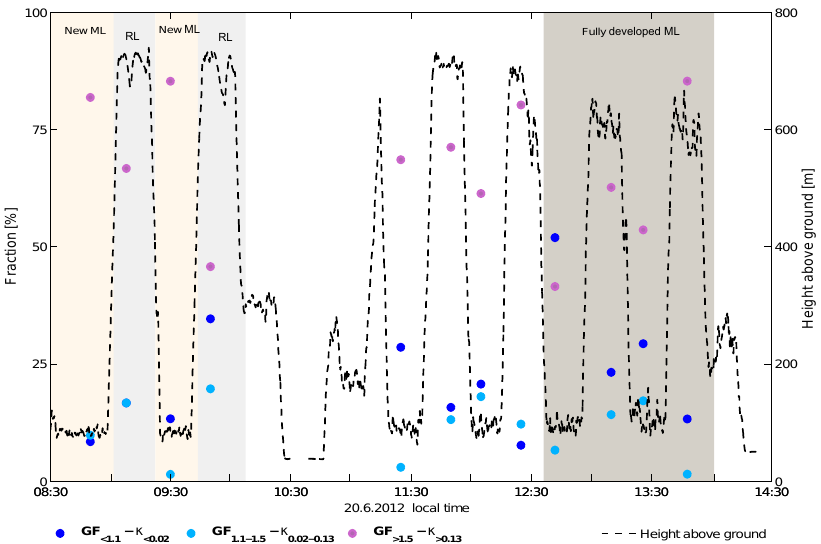
Figure 4. Time series of the mixing state of the aerosol particles (with D dry = 500nm) for the height profiles in Italy on 20 June 2012. Particles are classified into three hygroscopicity categories according to their GF: GF < 1.1, 1.1 < GF < 1.5, GF > 1.5, in blue, light blue and pink respectively; these are equivalent to κ < 0 . 02, 0 . 02 < κ < 0 . 13 and κ > 0 . 13. The black, dashed line denotes the flight altitude. The labelled, coloured areas refer to the layer which was probed at the certain